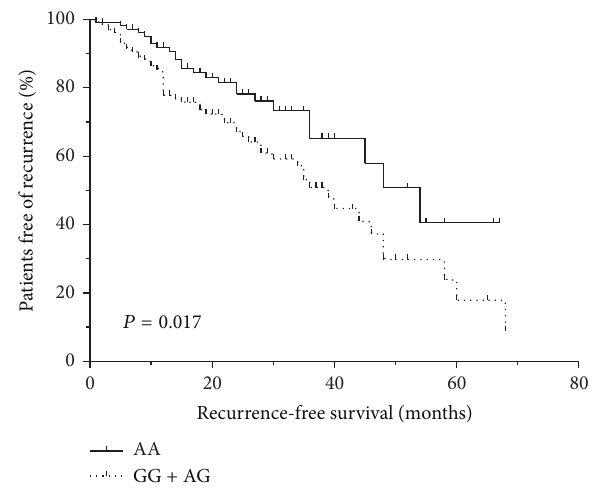
Figure 2: Kaplan-Meier survival curves for recurrence among bladder cancer cases based on TSP-1 -1223 A/G polymorphism genotypes. 𝑃 values were calculated by log-rank